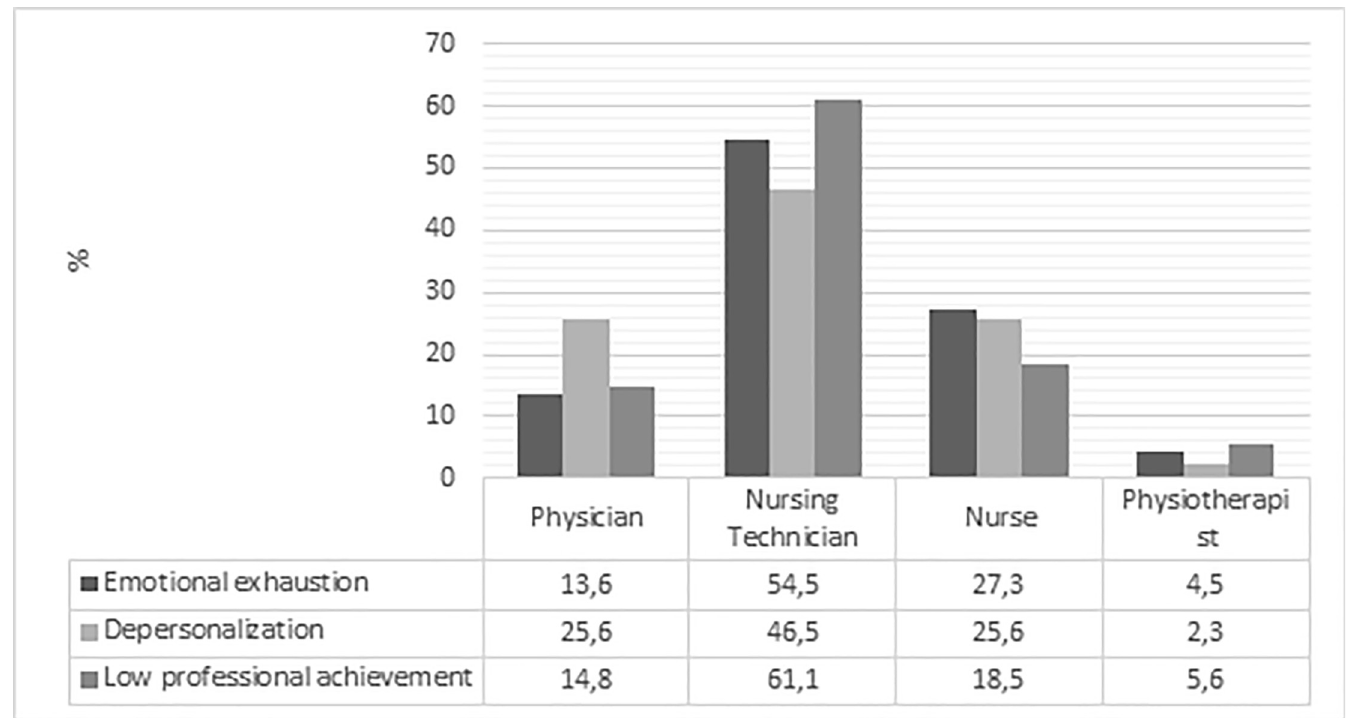
Fig 1. Burnout dimensions. Ceara´, Brazil, 2018.